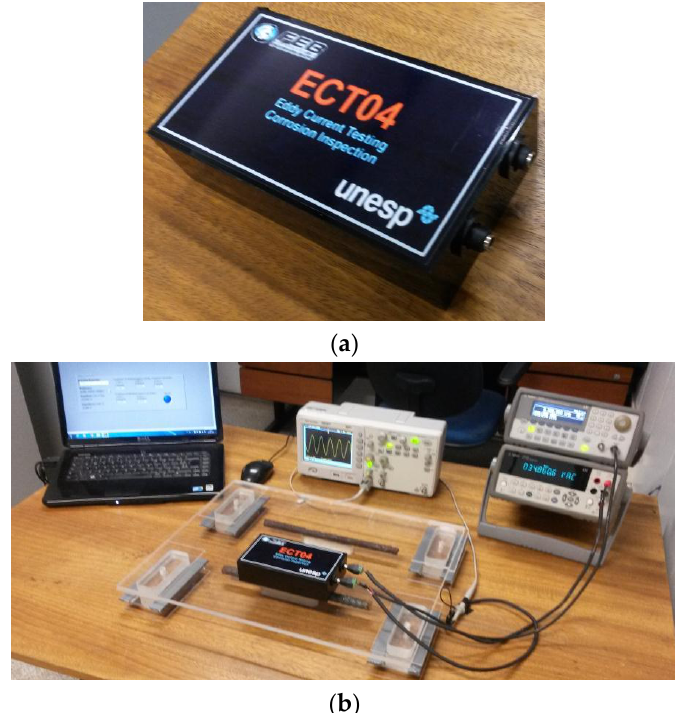
Figure 11. ( a ) An ECT sensor for corrosion inspection; ( b ) Experimental setup for the measurements.